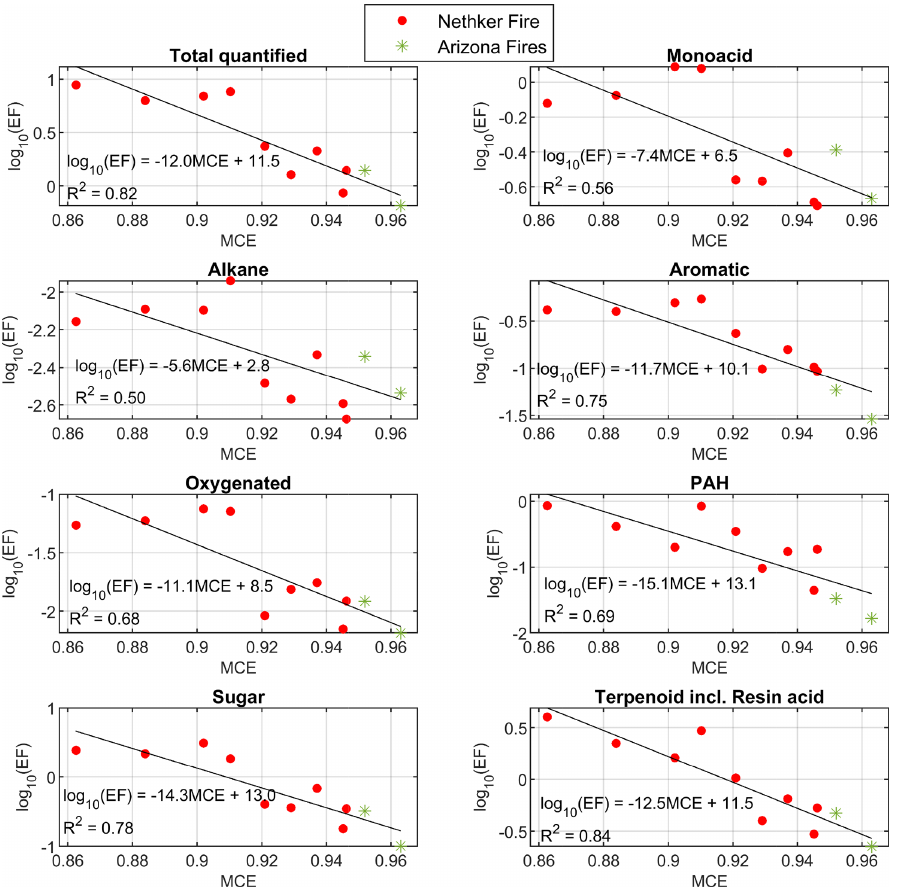
Figure 3. Summed emission factors for chemical classes as a function of MCE. Colors indicate the different fires. Black lines indicate the linear fits. Compounds in each class are given in the Supplement spreadsheet. Data points from the 204 Cow Fire did not meet the criteria to be used for EF